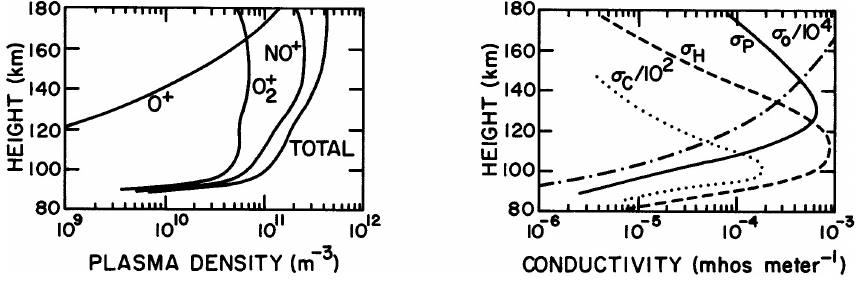
Fig. 1. Vertical profiles of daytime composition and plasma density (left) and conductivities (right) for average solar conditions (from Forbes and Lindzen, 1976.)